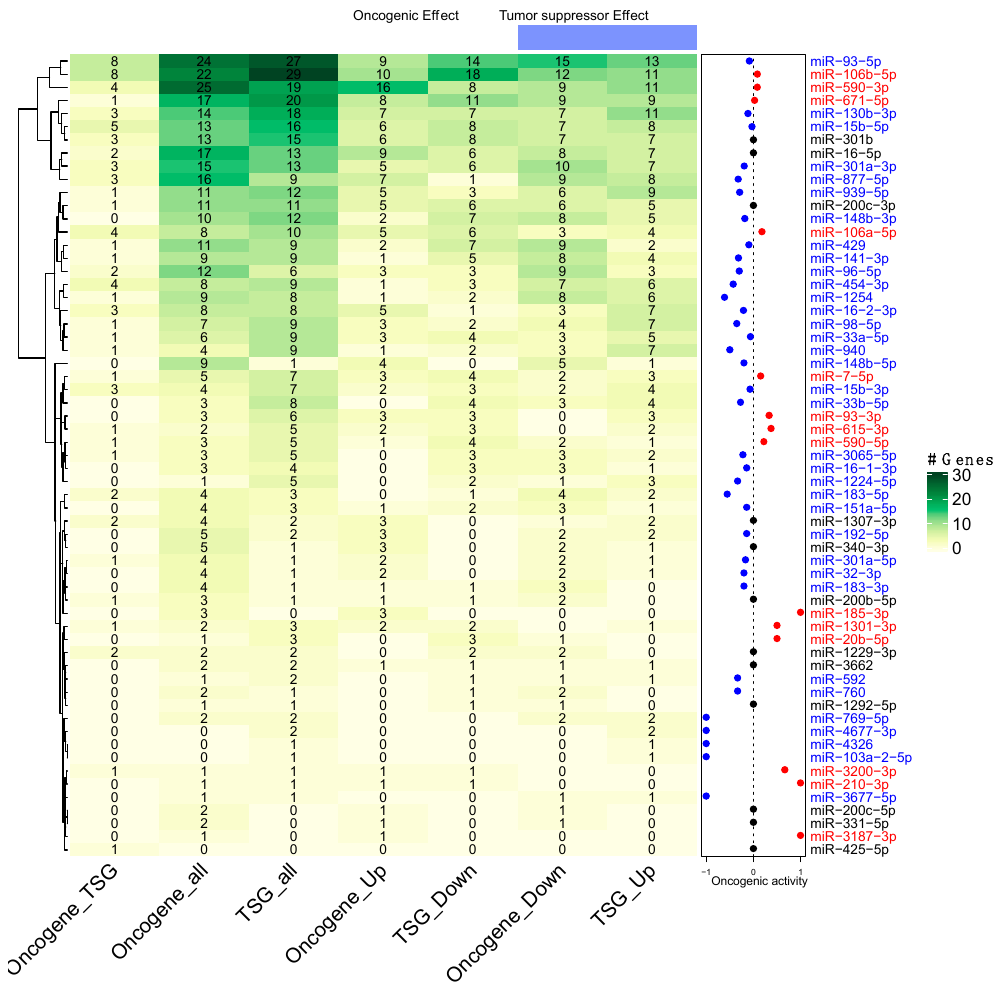
Figure 5. Oncogenic net activity of the 61 miRNAs. The heatmap shows the number of annotated oncogenes and tumor suppressors in the COSMIC database, where green represents a higher number of genes. The right dot plot represents each miRNA oncogenic activity, where blue shows a tumor suppressor activity, black a neutral activity, and red an oncogenic activity.